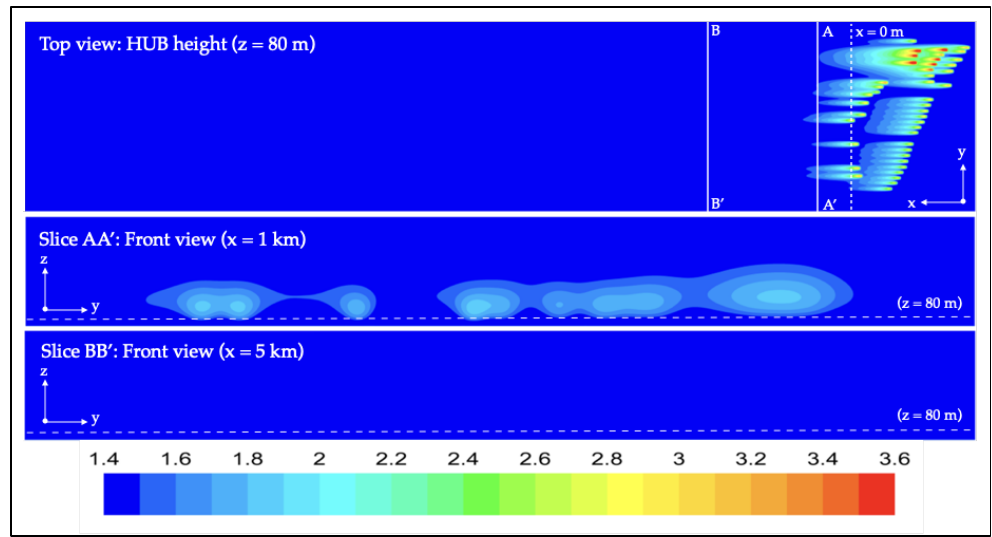
Figure 7. Turbulence kinetic energy k ( m 2 s 2 ⁄ ) at hub height against the ambient turbulence kinetic energy at 𝑇𝐼 = 15% .